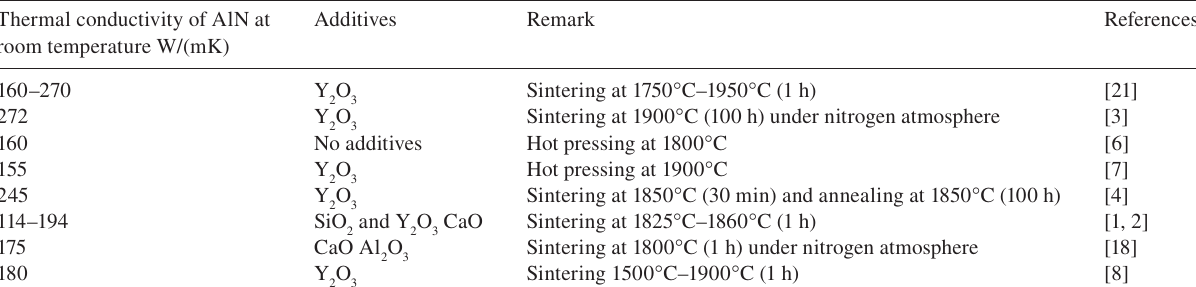
Table 2 Thermal conductivity of aluminum nitride.